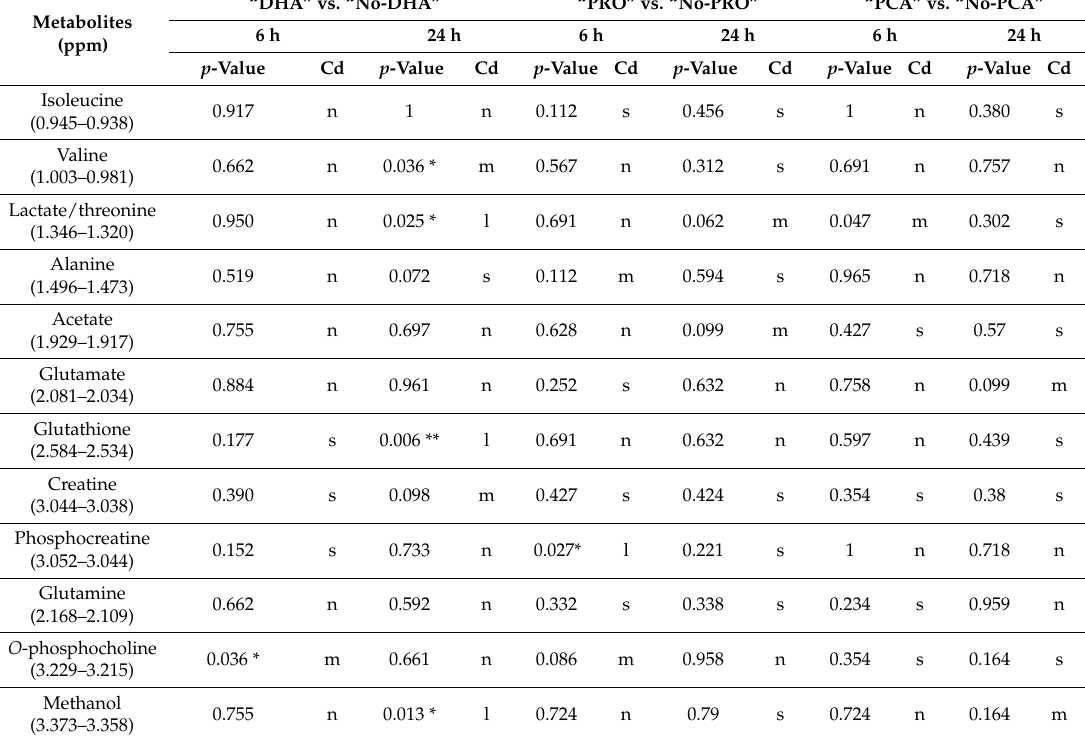
Table 4. List of metabolites whose signals were assigned and integrated in the nuclear magnetic resonance (NMR) spectra. For each metabolite, the integration range is reported. For each comparison, the corresponding p -value of the Wilcoxon test and the Cliff’s delta (Cd) effect size are reported (* p < 0.05; ** p < 0.01; *** p < 0.001, n = negligible, s = small, m = medium, l =